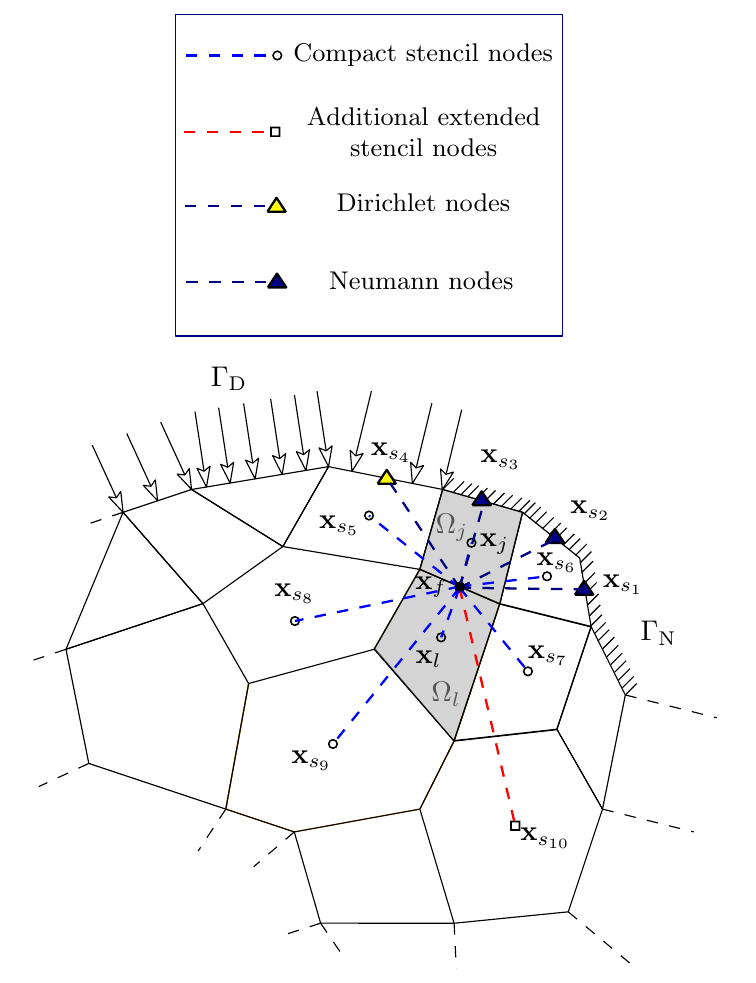
Figure 5. Face stencils with boundary